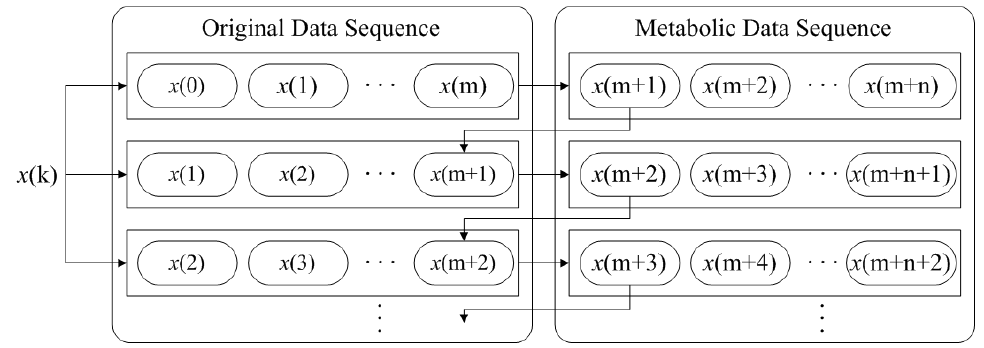
Figure 5. Diagram of rolling optimization strategy for MEGM(1,1).